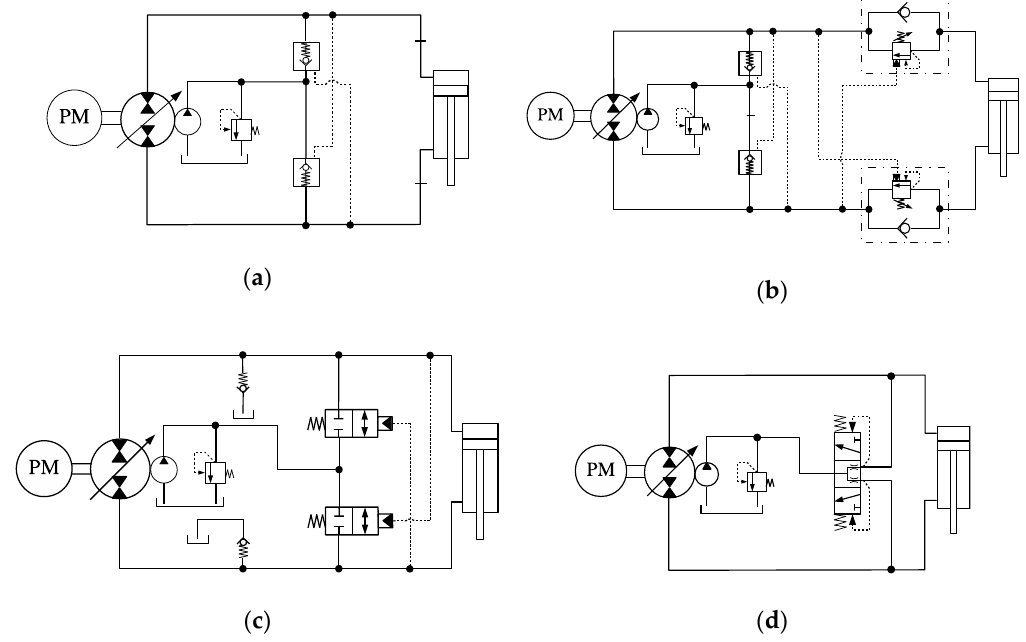
Figure 1. Single-rod hydrostatic actuators using compensation directional valves: ( a ) circuit with piloted check valves [6]; ( b ) circuit with piloted check valves and counterbalance valves [7]; ( c ) circuit with two directional valves [13]; ( d ) circuit with one directional valve [8].